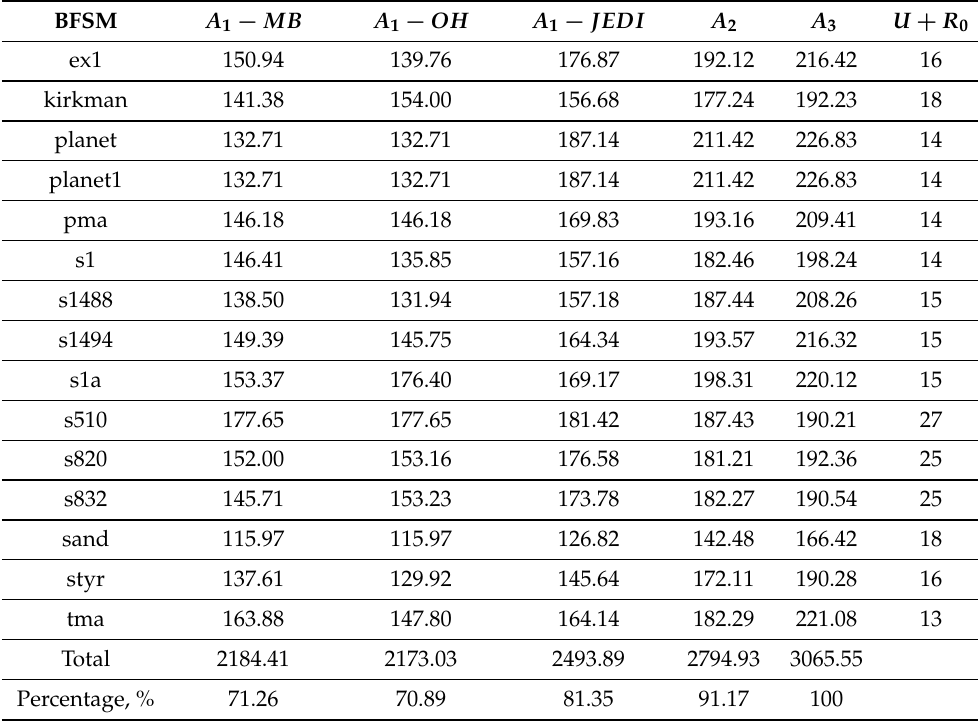
Table 11. Results of experiments (maximum operating frequency,